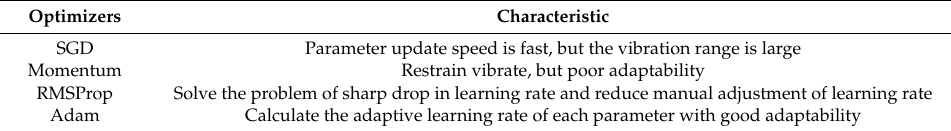
Table 5. The characteristic of the optimizers of DNN.